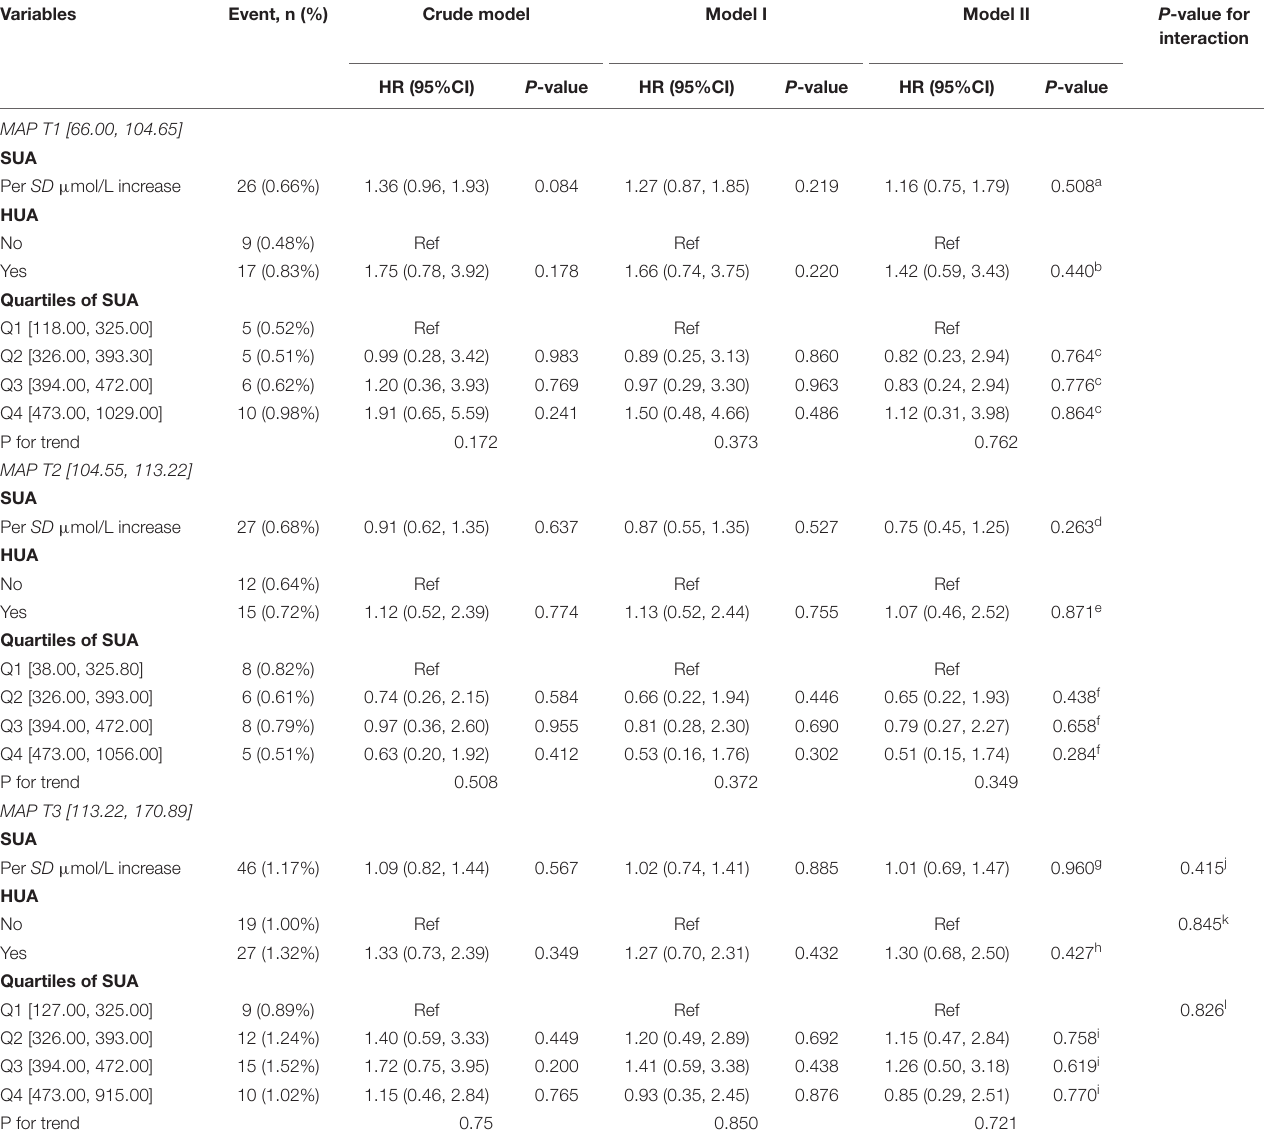
TABLE 6 | Hazard ratios of serum uric acid level categories for total first stroke events by mean arterial pressure tertiles in different models. Variables Event, n (%) Crude